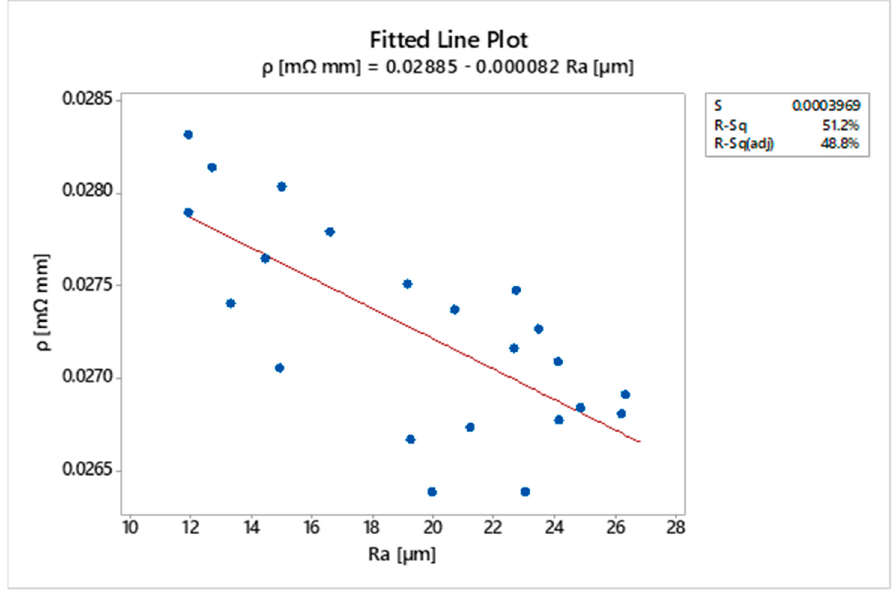
Figure 9. Regression analysis: ρ vs. Ra ( p -value = 0.000).